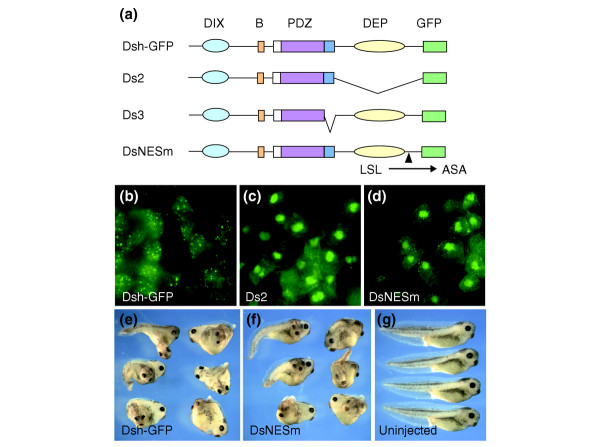
Nuclear export of Dsh is not critical for its activity. (a) The Dsh constructs used to analyze nuclear export. (b-d) RNAs encoding Dsh-GFP, Ds2 and DsNESm (0.5 ng each) were injected into two animal blastomeres of 4–8-cell embryos. Animal-cap explants were excised at stage 10, fixed and examined for GFP fluorescence. (b) Wild type Dsh-GFP localized in punctate structures of the cytoplasm, whereas (c) Ds2 and (d) DsNESm accumulated in the nucleus of animal pole cells. (e,f) One ventral vegetal blastomere of 8-cell embryos was injected with 1 ng Dsh-GFP or DsNESm RNA as indicated. Complete secondary axes were induced in both cases. (g) Uninjected sibling embryos.